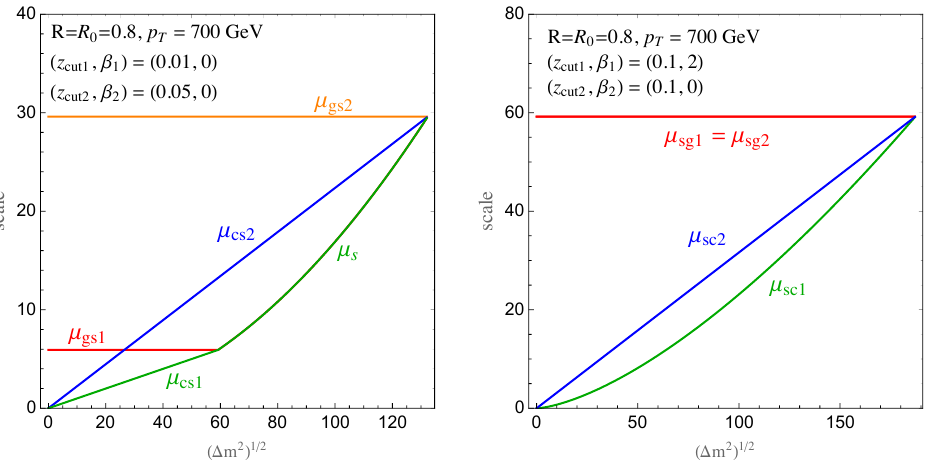
Figure 8 . Plots of the canonical scales for collinear drop, including the merging of (cid:22) gs 1 and (cid:22) cs 1 at the transition where the SD 1 grooming becomes ine(cid:11)ective at ((cid:1) m 2 upper endpoint of the spectrum occurs at ((cid:1) m 2 and depends on the collinear drop parameter z cut2 via eq.